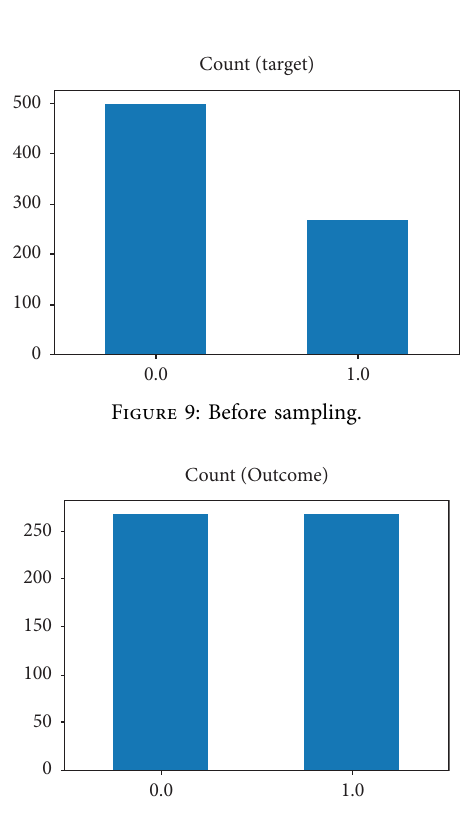
Figure 10: After sampling.